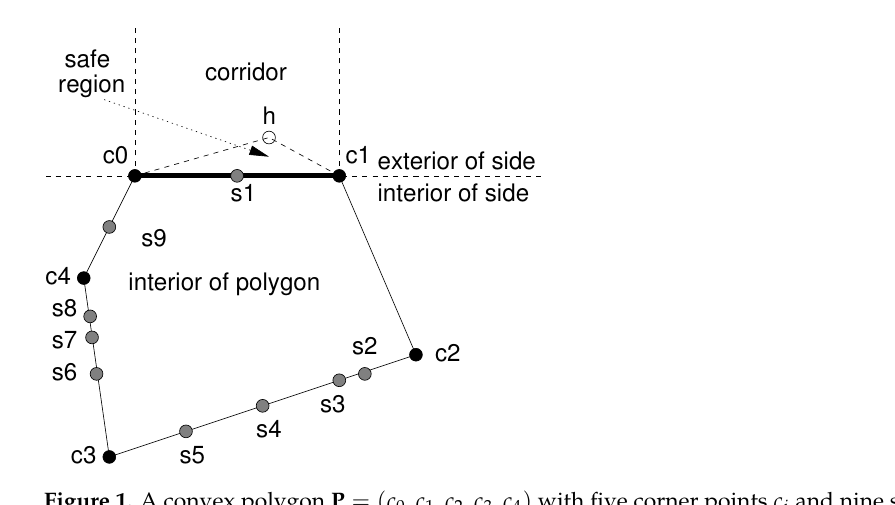
Figure 1. A convex polygon P = ( c 0 , c 1 , c 2 , c 3 , c 4 ) with five corner points c i and nine side points s j